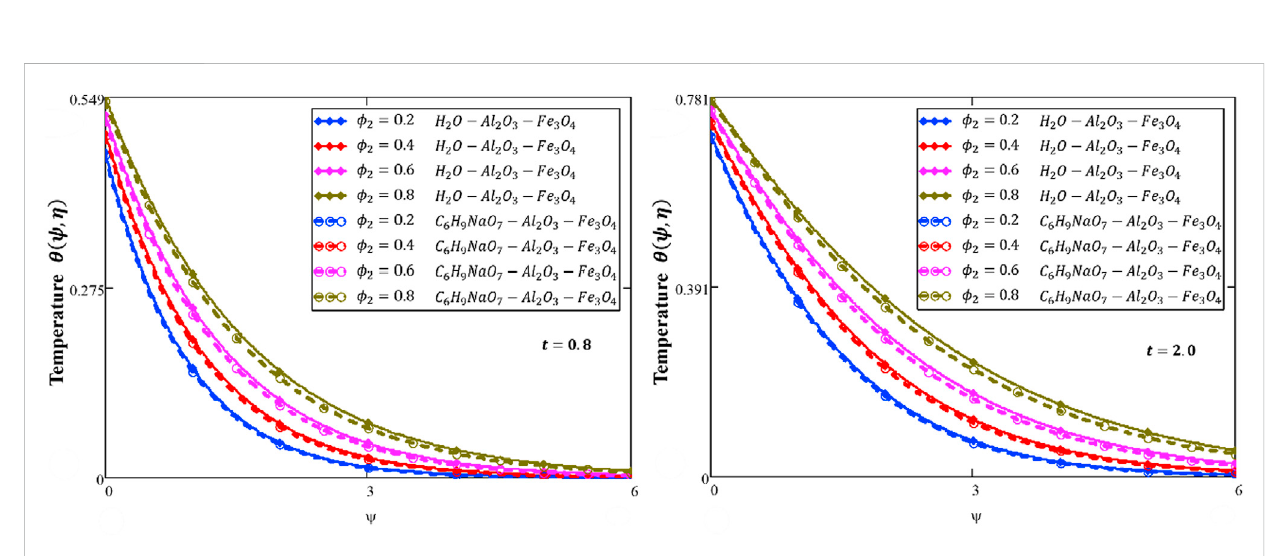
FIGURE 5 Simulation to explain the temperature for changing ϕ 2 when Pr (cid:3) 2 , α (cid:3) 0 . 8 , and ϕ 1 (cid:3) 0 . 2.